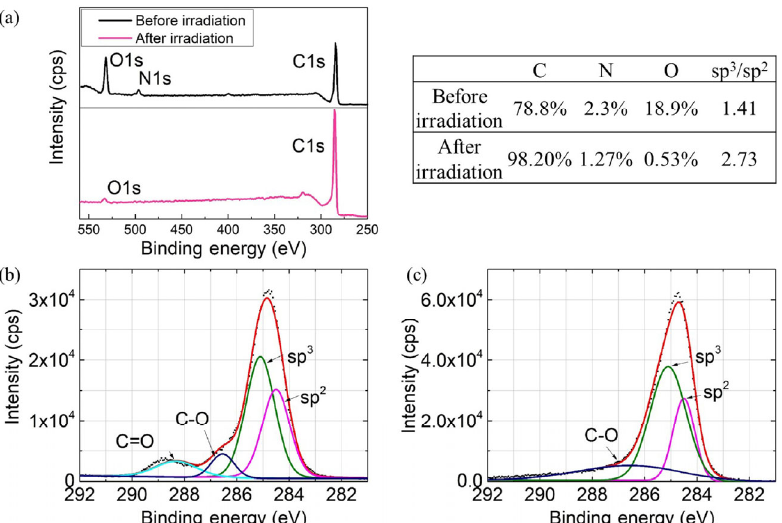
Fig. 4 XPS data for the graphite mesa edges. (a) XPS spectra of graphite edge before and after Argon plasma irradiation, and table showing a percentage of elements present at the edges. C1s spectra of the graphite edge before (b) and after (c)